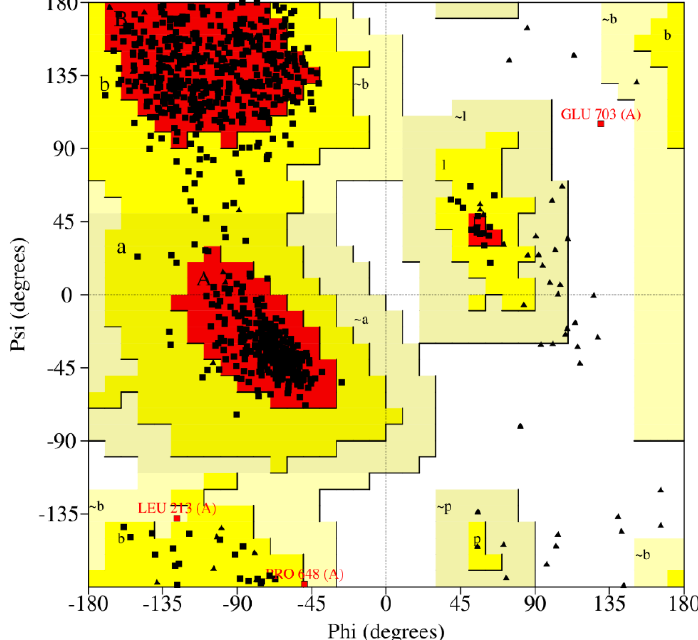
Figure 4. Ramachandran plot of Alpha Glucosidase, which represents most favored and favored regions and additional allowed regions. regions and additional allowed